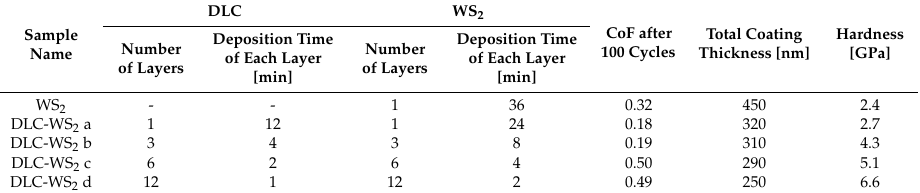
Table 3. Deposition times and properties of DLC-WS 2